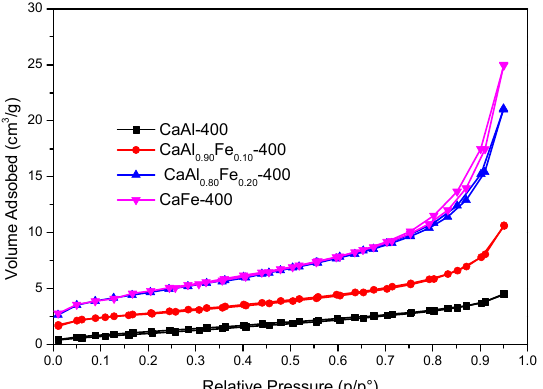
Figure 8. Nitrogen adsorption–desorption isotherms of samples calcined at 400 °C. Table 2. S BET and average pore diameter of samples calcined at 400 °C.